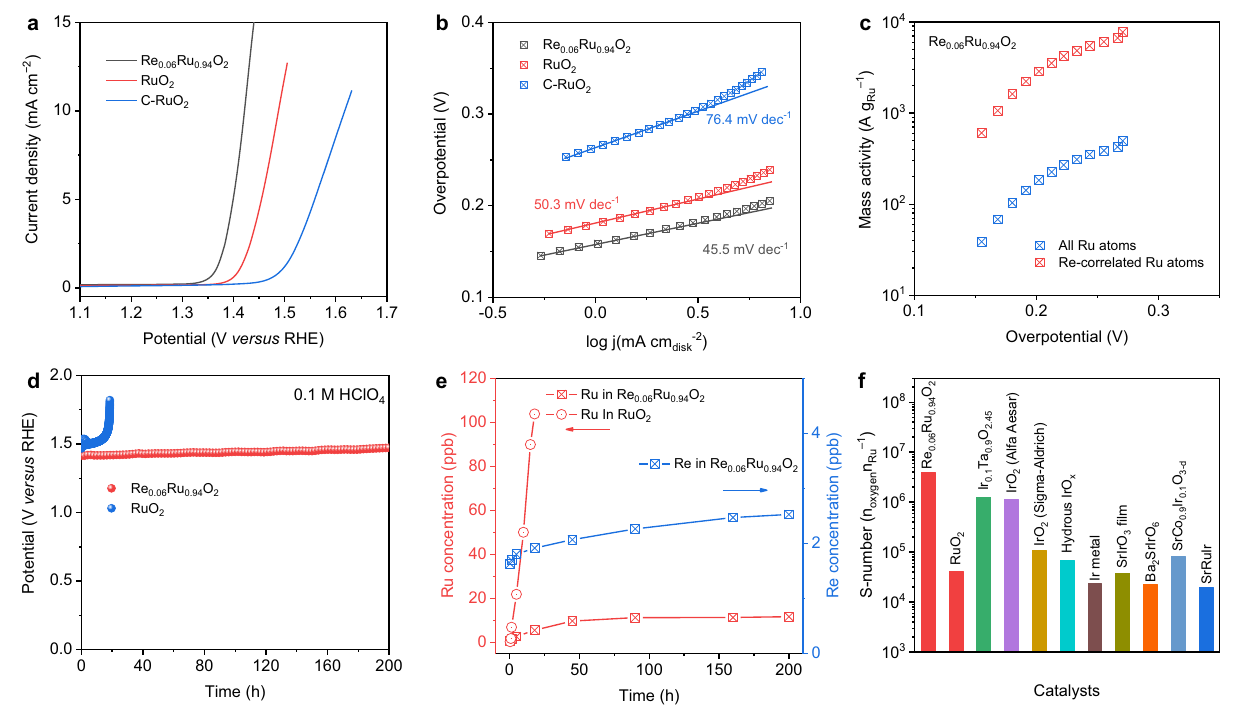
Fig. 1 | OER performance. a LSV curves and b Tafel plot for Re 0.06 Ru 0.94 O 2 , RuO 2 , and commercial RuO 2 in O 2 -saturated 0.1M HClO 4 (RHE=reversible hydrogen electrode). c Comparison of mass activity for Ru atoms in Re 0.06 Ru 0.94 O 2 as a function of overpotential. d Constant current chronopotentiometric stability